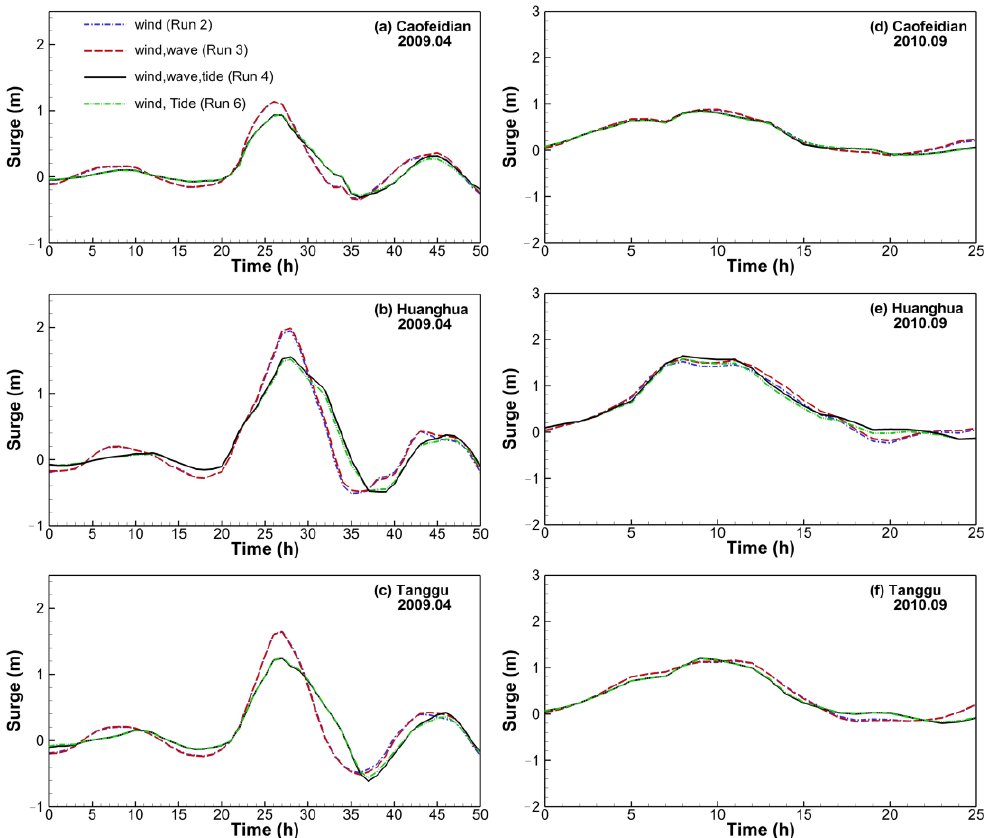
Figure 12. Simulated surges at Caofeidian (panels ( a , d )), Huanghua (panels ( b , e )), and Tanggu (panels ( c , f )) during the 2009 event (panels ( a – c )) and 2010 events (panel ( d – f )) with consideration of wind (run 2, dashed blue line), wind and waves (run 3, dashed red line), wind, waves and tide (run 4, black line) and wind and tide (run 6, dashed green line).